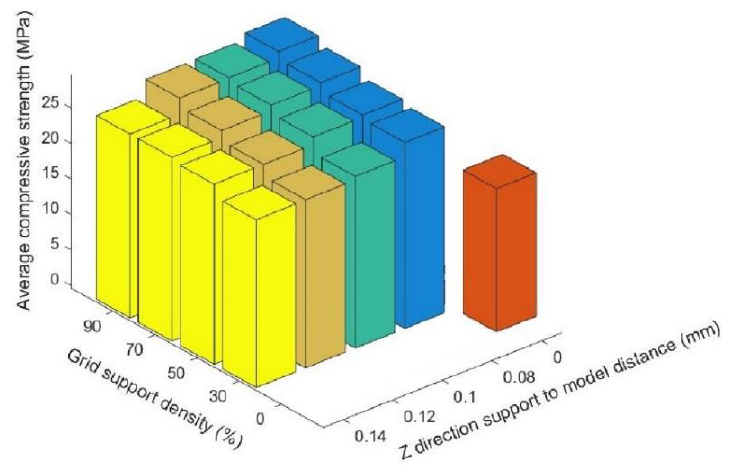
Figure 11. Relationship between density and Z direction support-to-model distance — average compressive strength under grid support.